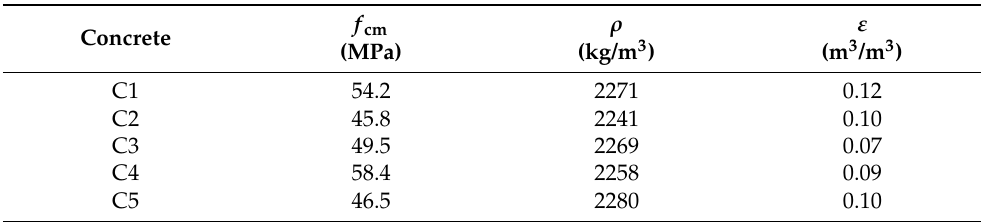
Table 3. Mean compressive strength ( f cm ), bulk density ( ρ b ), and open porosity ( ε ) of tested concretes (data also partially published in [21]). Concrete